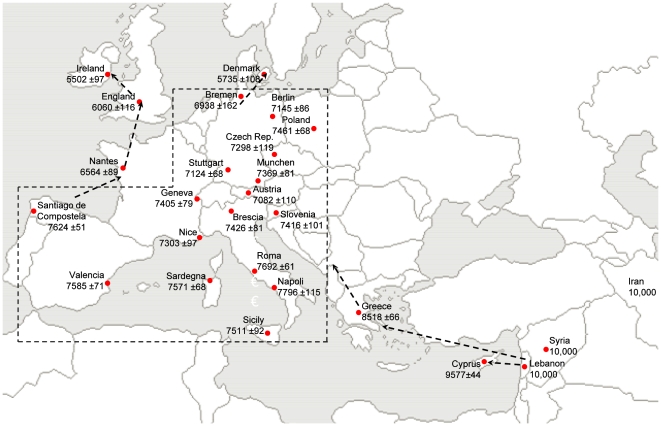
Map location of European and Near-Eastern populations used for the computer simulation.Dots locate the populations used for computer simulation (Note that the Iran sample should be located farther East, outside of the map). When more than one population from the same country were used, the name of the corresponding city is given (see Table 3). Below each population name, the approximate date of domestication and its standard error (years BP) are mentioned. When simulating the Demic Diffusion hypothesis (DD), dotted arrows show the simulated relations between population source and "new founded" populations (regarding initial frequency of LCT*P, see Material and Methods and Supplementary Information). To facilitate reading, the dotted area regroups populations for which we use Greece as the source.